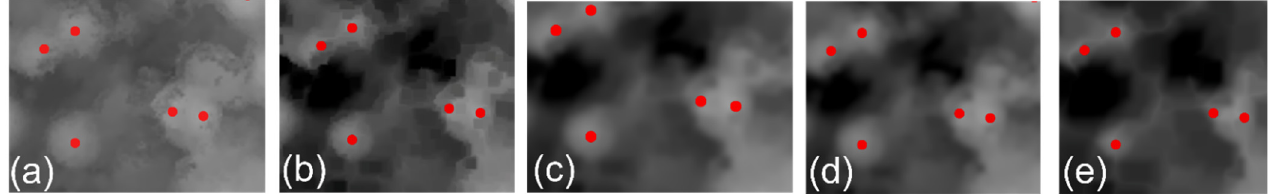
Figure 6. Image morphological operations cycle on ( a ) CHM with manual treetop annotation, ( b ) erosion, ( c ) Gaussian blur, ( d ) dilation, and ( e ) erosion.